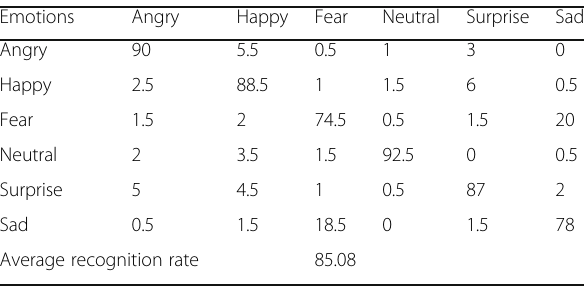
Table 14 Emotion recognition rates of decision tree SVM with parameter optimization and feature selection (CASIA) (%) Emotions Angry